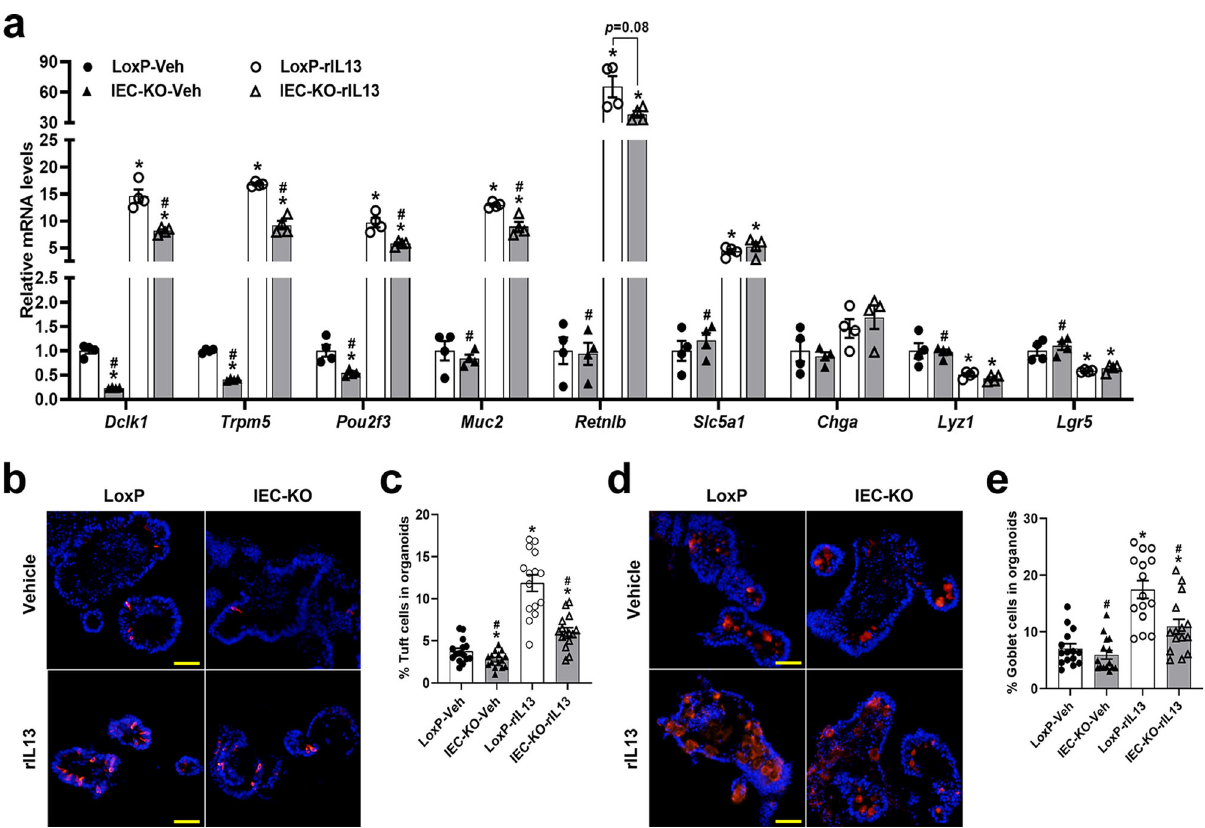
b , d Tuft and goblet cells were labeled by anti-DCLK1 ( b ) and anti-MUC2 ( d ), respectively, in frozen sections of organoids (200X). c Quanti fi cation of tuft cells shown in ( b ). n =15 organoids/group; from left to right, * p =0.0301, <0.0001, 0.001; # p <0.0001 for both. e Quanti fi cation of goblet cells shown in ( d ). n =15 organoids/group;fromlefttoright,* p <0.0001,0.0176;# p <0.0001,0.0032.Data are presented as mean±SEM. All p values were generated by two-tailed unpaired t test. * p <0.05 vs LoxP-Veh, # p <0.05 vs LoxP-rIL13. Scale bars, 50 µ m. Source data are provided as a Source Data fi